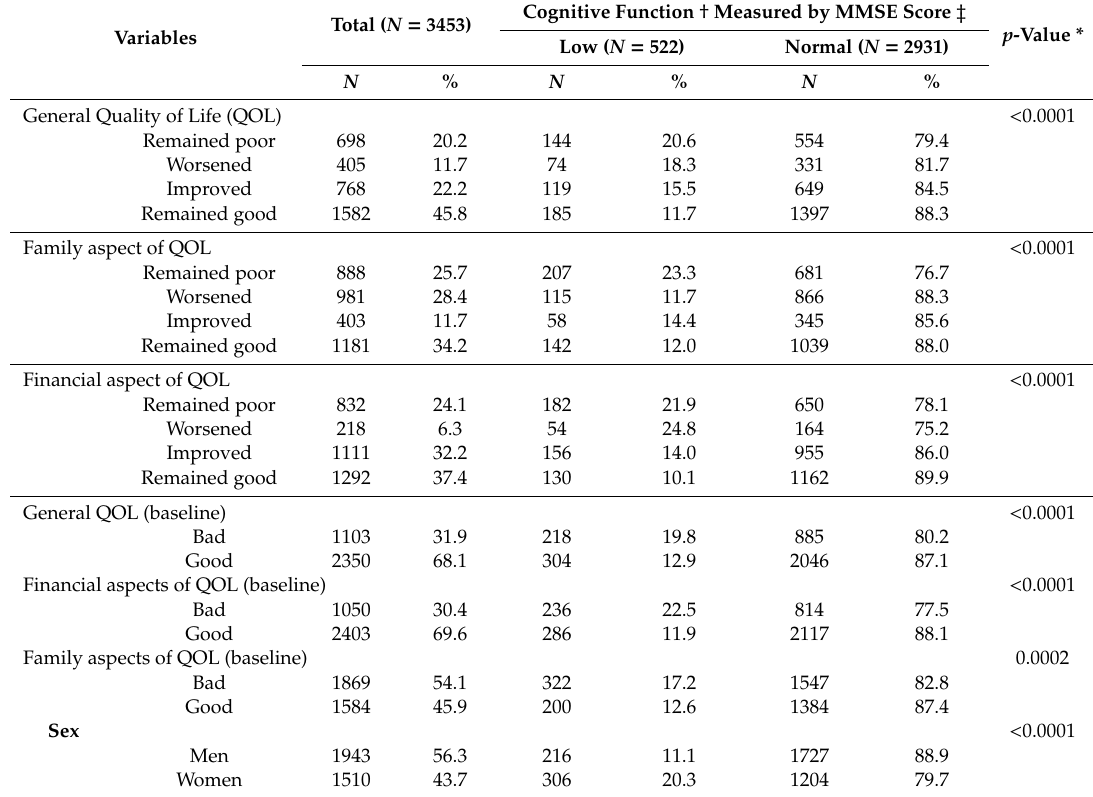
Table 1. General characteristics of the study population in